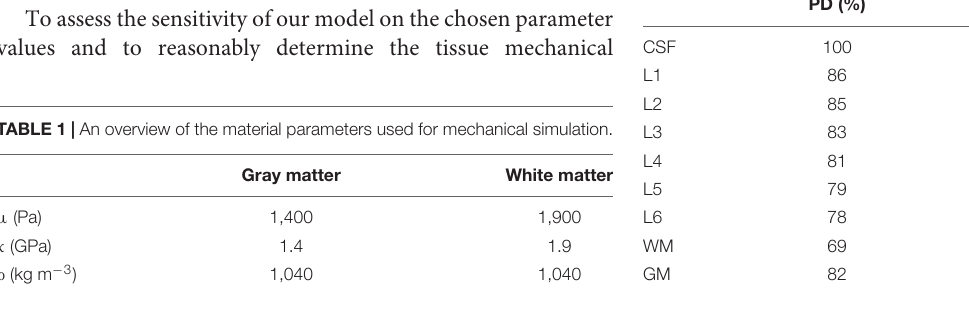
TABLE 2 | Values for proton density (PD), T1, T2* for different tissue types and cortical layers (L1–6) at 7 Tesla used in the simulations. PD